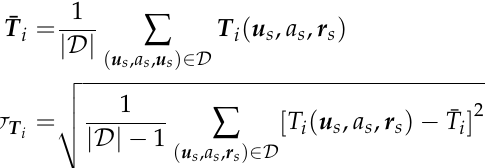
( 1 ) over the dataset . ( b ) The 0 D ( 2 ) over the dataset . In both panels, the 0 D